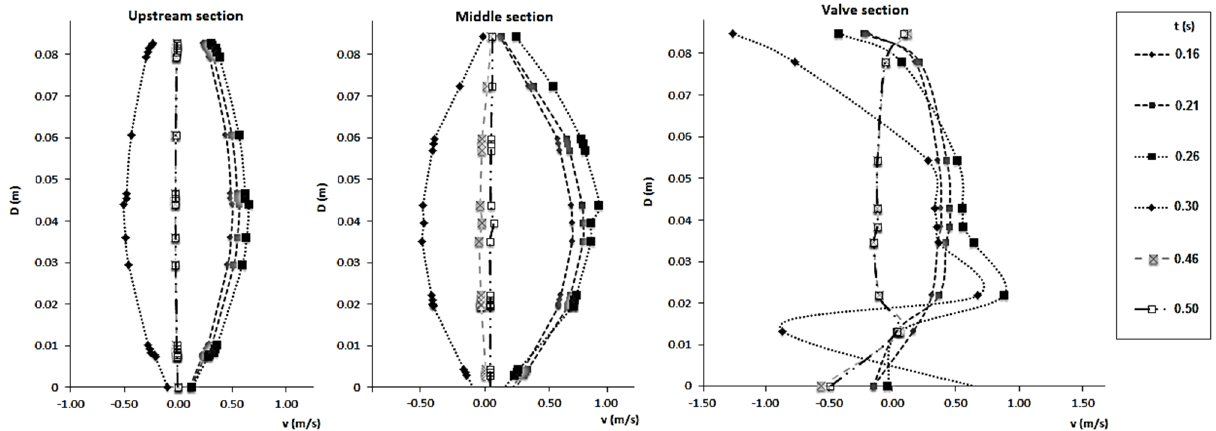
Figure 15. Velocity profiles in three pipe locations: upstream, middle, and valve